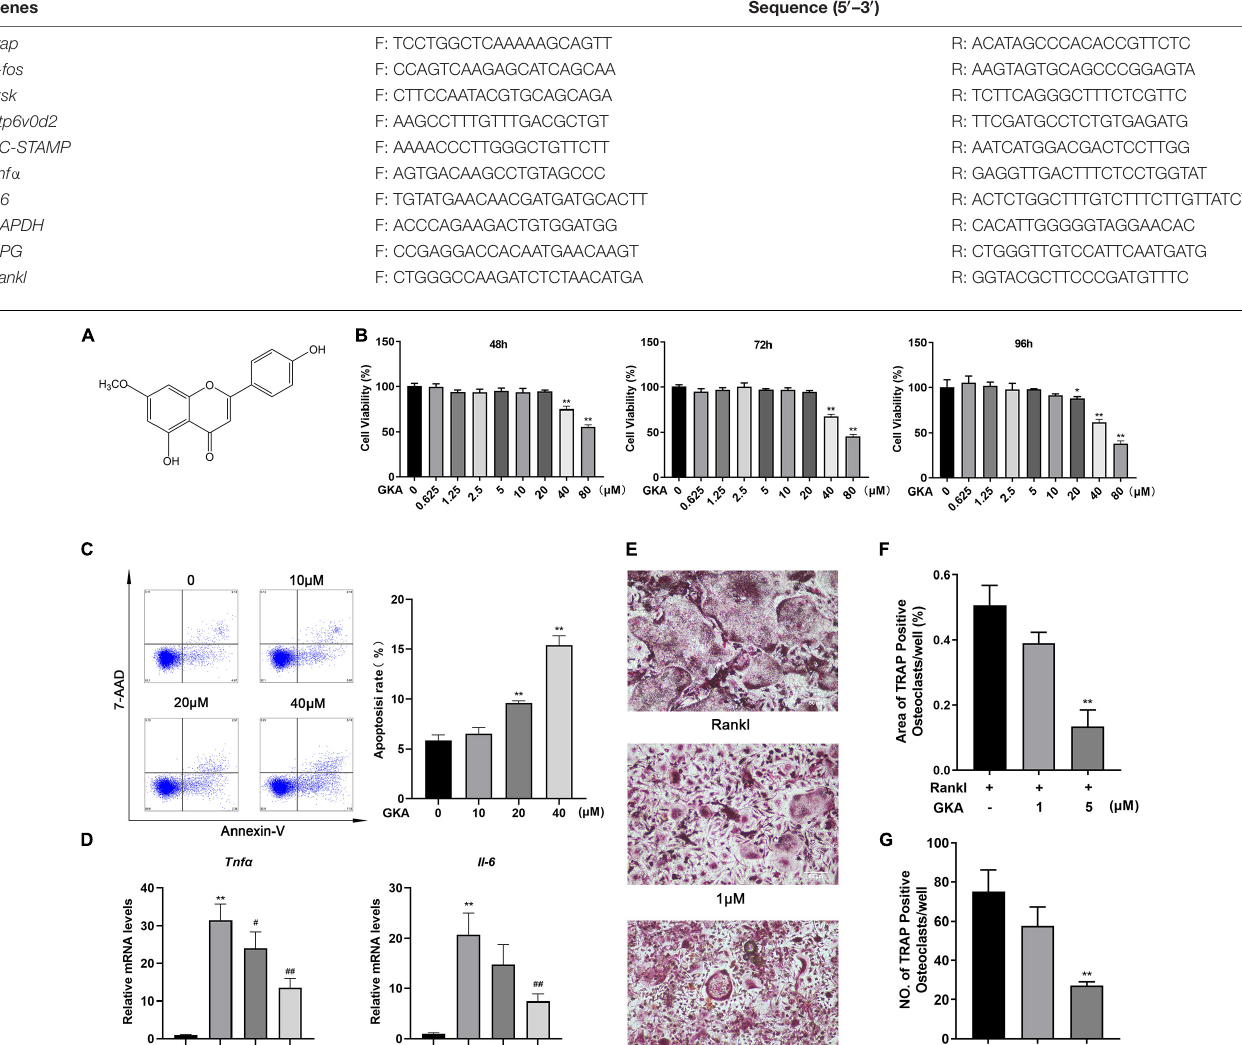
TABLE 1 | Primer sequences used for RT-PCR.